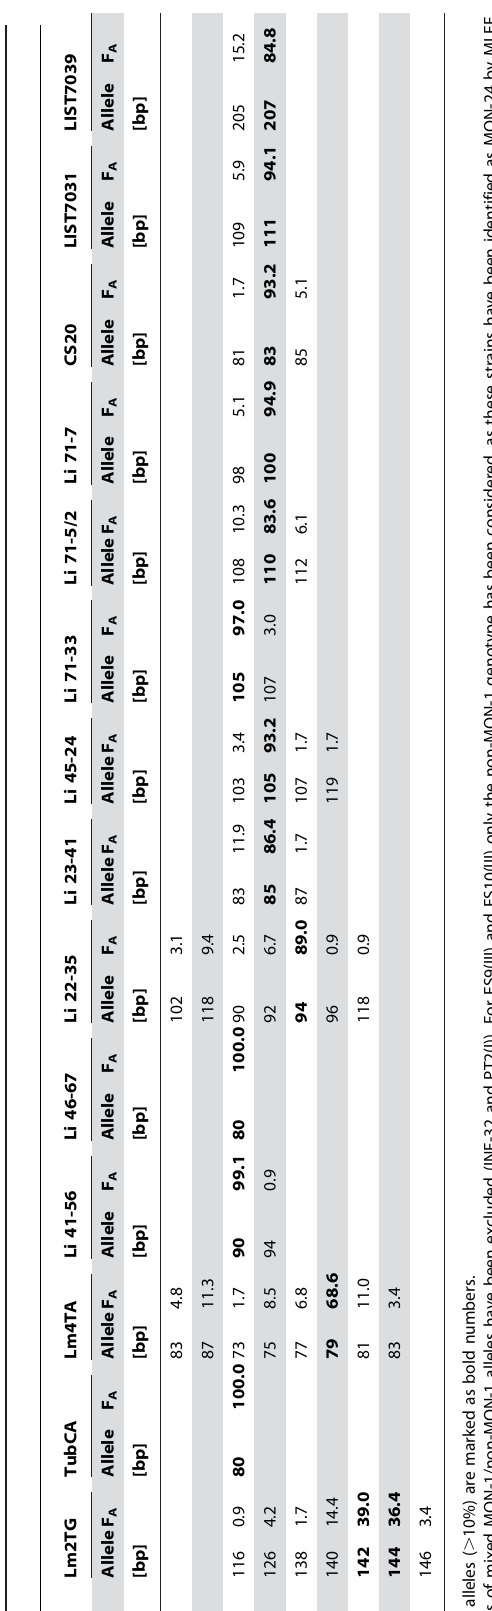
( Table 4 ). In addition, four loci also had unique alleles in relation to all other Portuguese strains: LIST7031 (109 bp), Lm4TA